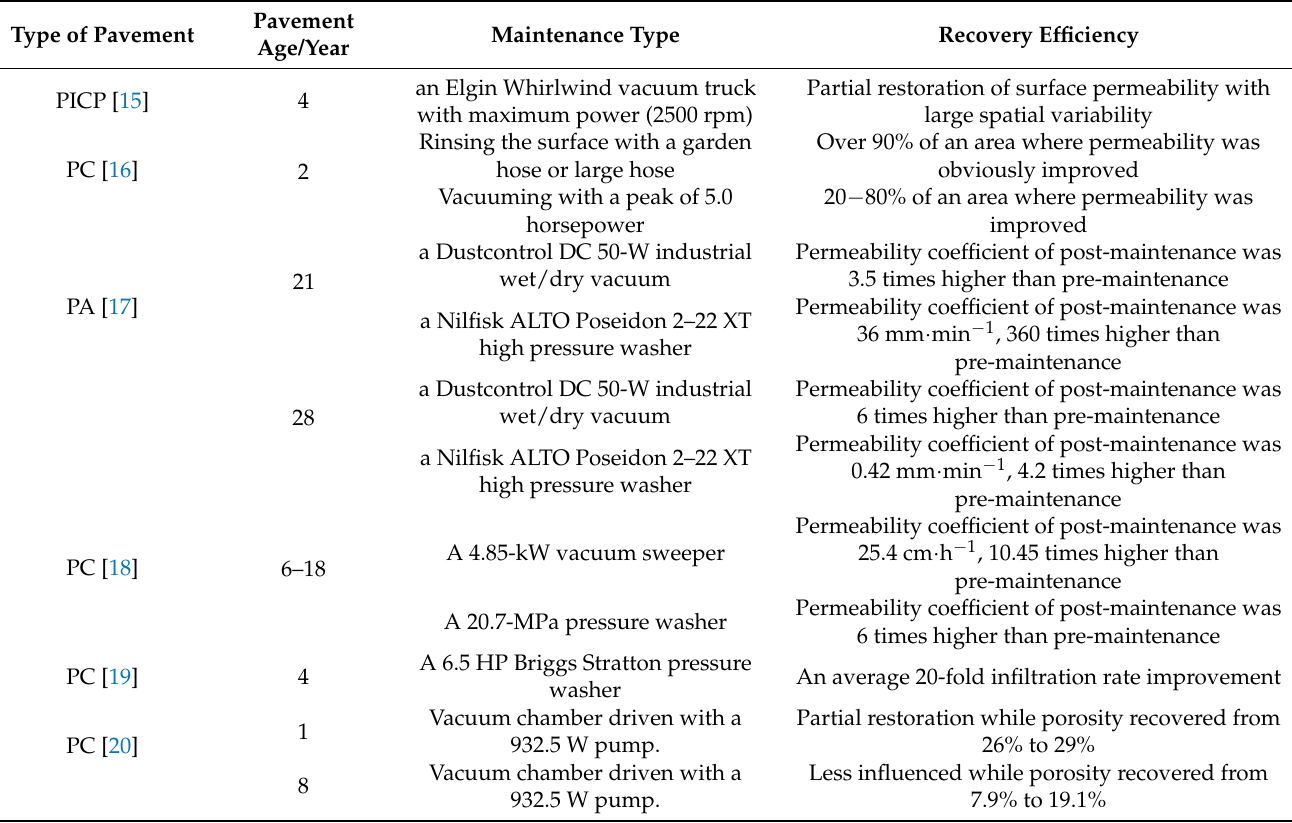
Table 1. Recovery measures and effects of different permeable